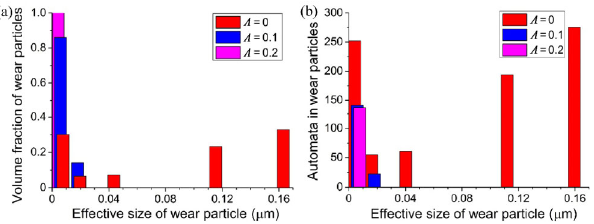
Fig. 15 Volume fractions (a) and mass contributions (b) of different size wear particles for three considered model ceramic materials with  = 0 (red columns),  =0.1 (blue columns) and  = 0.2 (magenta columns). Mass contributions are shown in arbitrary (automata amount)